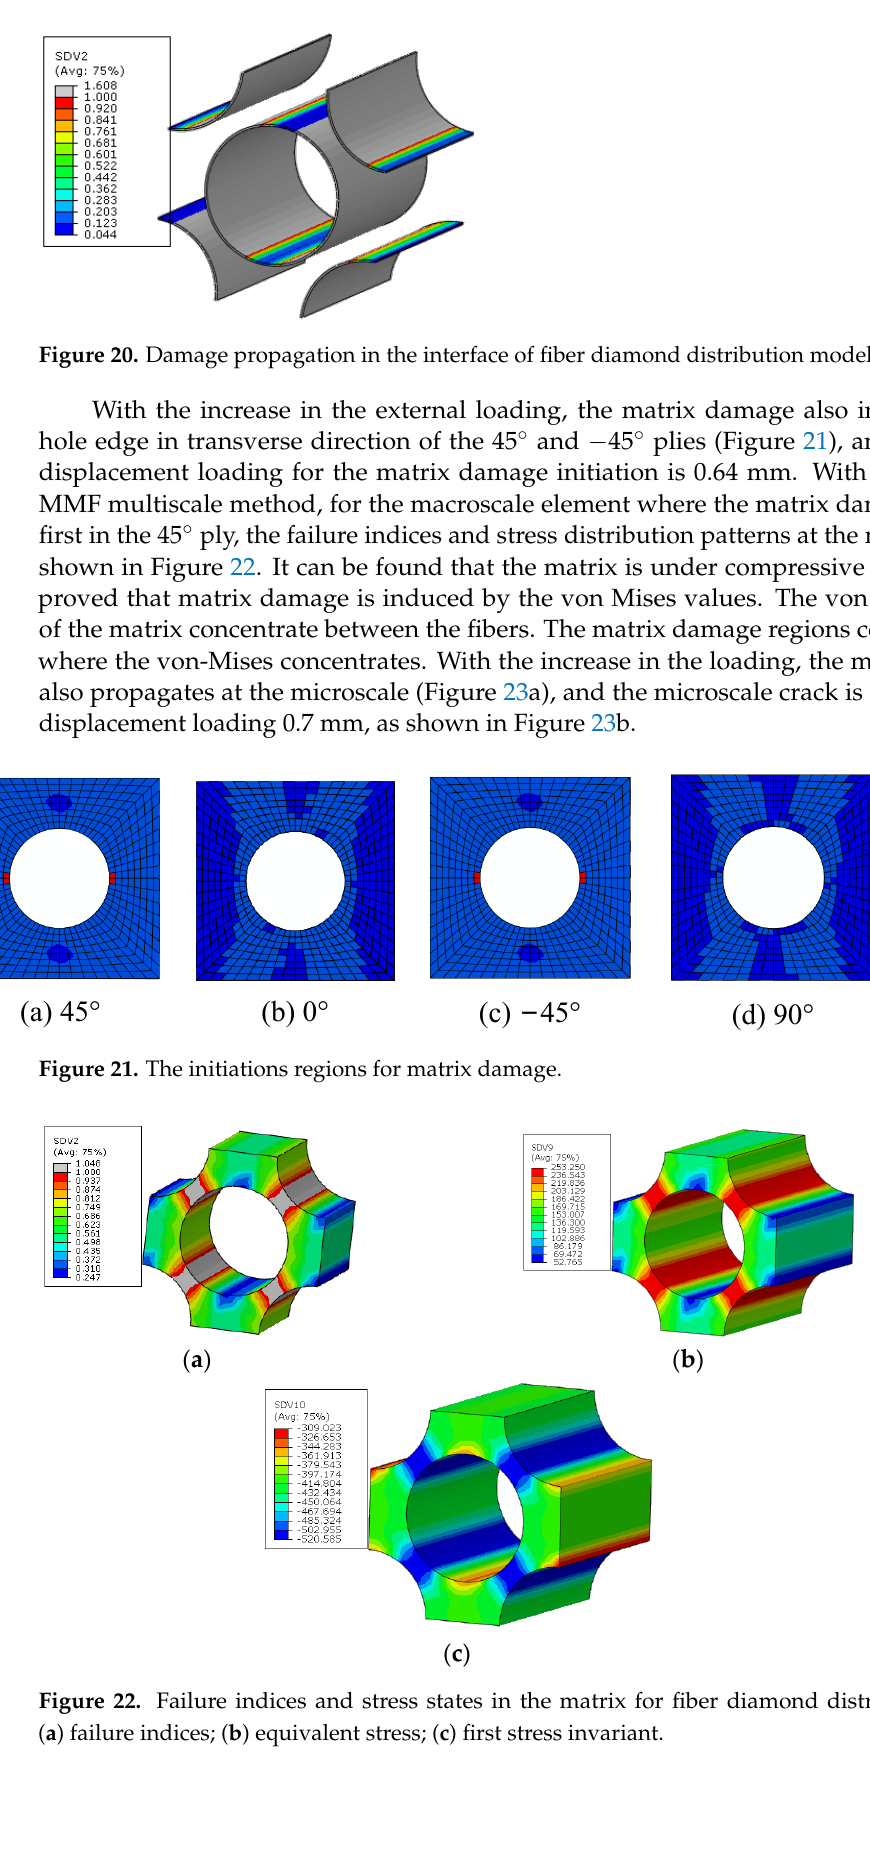
( b ) Figure 23. Matrix damage propagation in the matrix for fiber diamond distribution model. ( a ) at displacement loading 0.66mm; ( b ) at displacement loading 0.7 mm. The fiber breakages initiate around the hole in the 0° ply (Figure 24), and the critical displacement loading for the matrix damage initiation is 0.62 mm. It can also be found that the fiber breaks earlier than the matrix failure, which is consistent with the conclusion obtained from Ref. [16]. For the macroscale element where the fiber breakage initiates first, the microscale failure indices and the stress in the fibers are shown in Figure 25. It can be found that the stress in the fibers along the longitudinal direction are in the compressive stress states. Besides, the stress values in the RVE are almost the same, which contributes to almost the same failure indices in the RVE. It means that all the fiber clusters fail at almost the same time, which demonstrates the validity of adopting the sudden degrada- tion method for fiber breakage ( d f ).